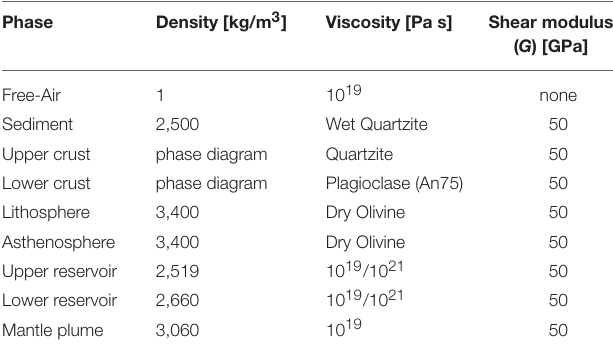
TABLE 2 | Material properties used in this